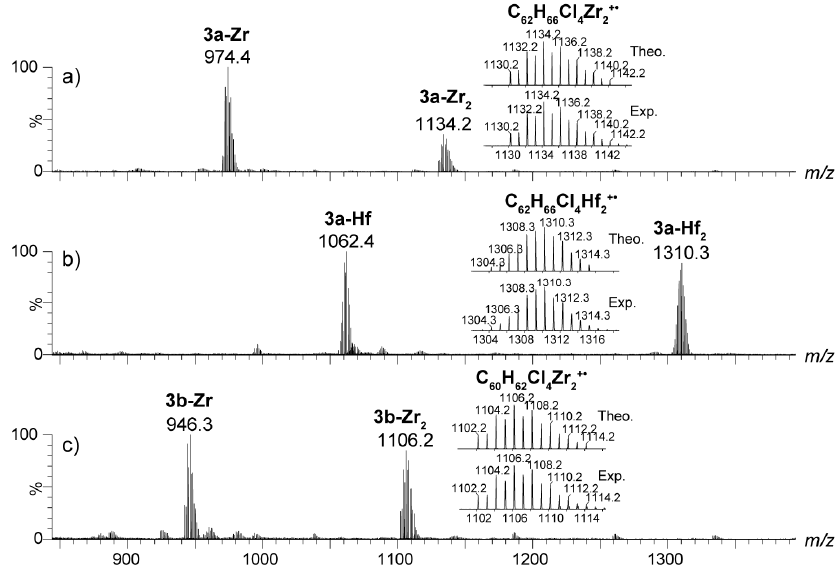
Figure 2. The APPI(+) mass spectra of the dinuclear bis(metallocene) 3a-Zr 2 ( a ), 3a-Hf 2 ( b ), and 3b-Zr 2 ( c ) complexes. The zoomed areas showcase the theoretical and experimental isotopic clusters. For each isotopic distribution, only the most intense isotope peak is labelled.